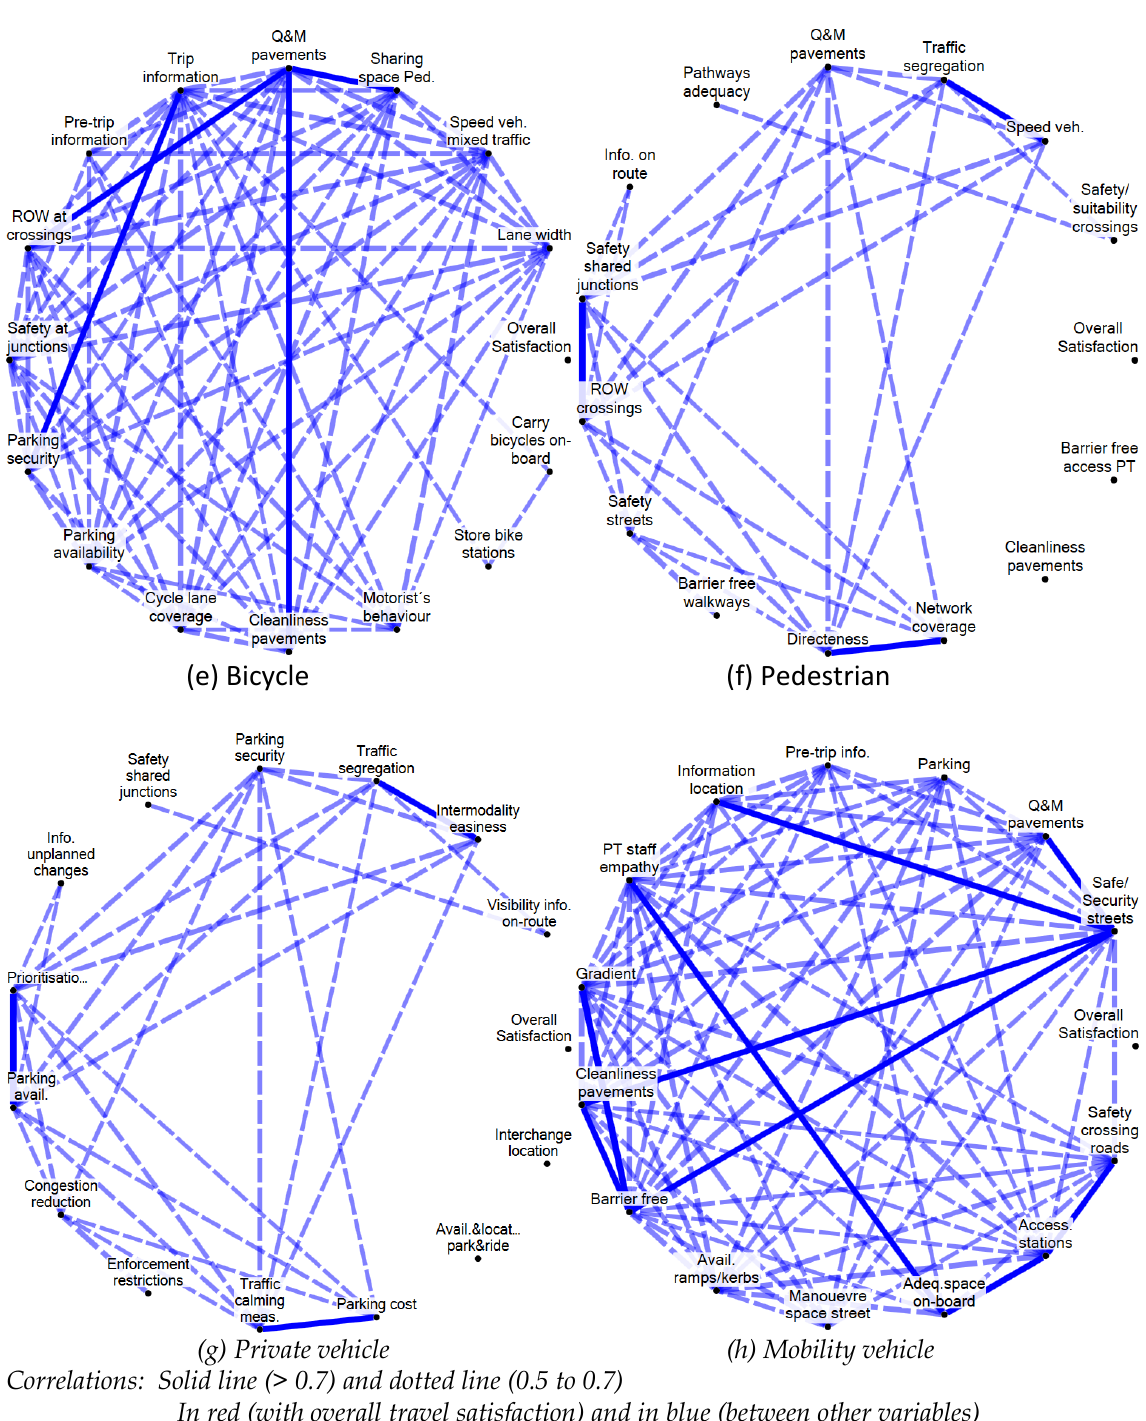
Figure 5. Cross-correlations among travel experience aspects and overall satisfaction on trip stages for different travel modes